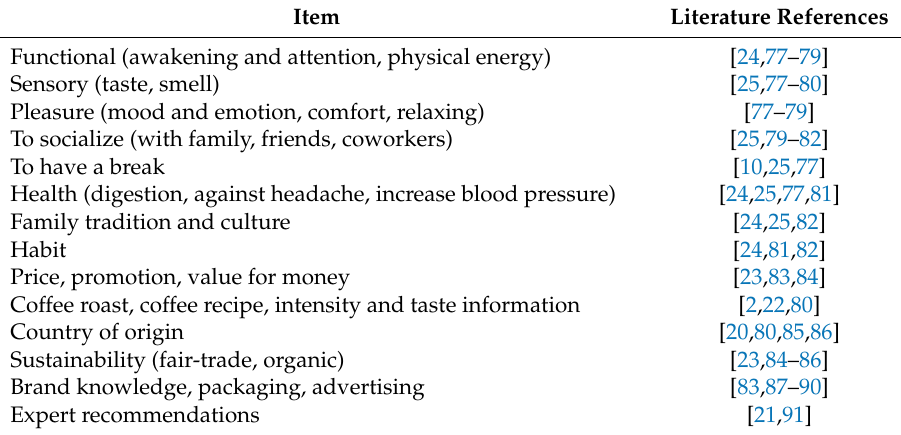
Table 2. Literature references for studied items in the